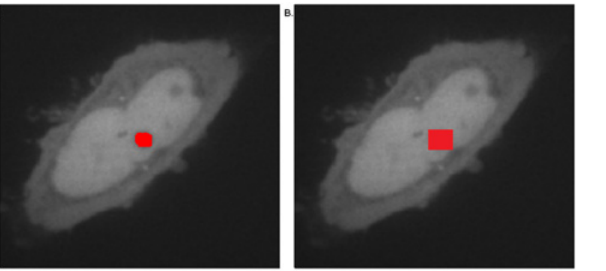
Fig 5. Comparison of automated selection methods for demarcating Regions of Interest (ROI) applied to the nucleoli. (A) Nucleolar ROI selection using a seeded region growing algorithm; (B) Nucleolar ROI selection using a fixed area around a selected